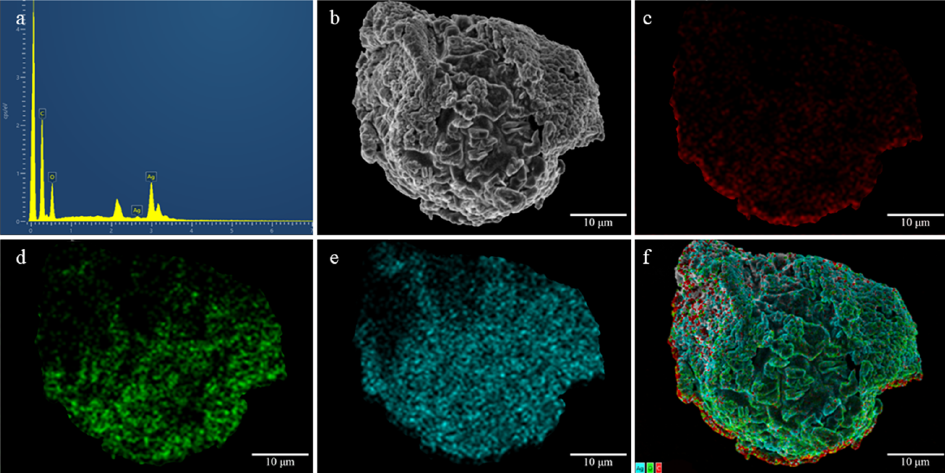
Figure 3. ( a ) EDX energy spectrum analysis, ( b ) SEM mapping of Ag NPs-BSP including ( c ) Carbon, ( d ) Oxygen, ( e ) Ag, and ( f ) merge. ( d ) Oxygen, ( e ) Ag, and ( f )